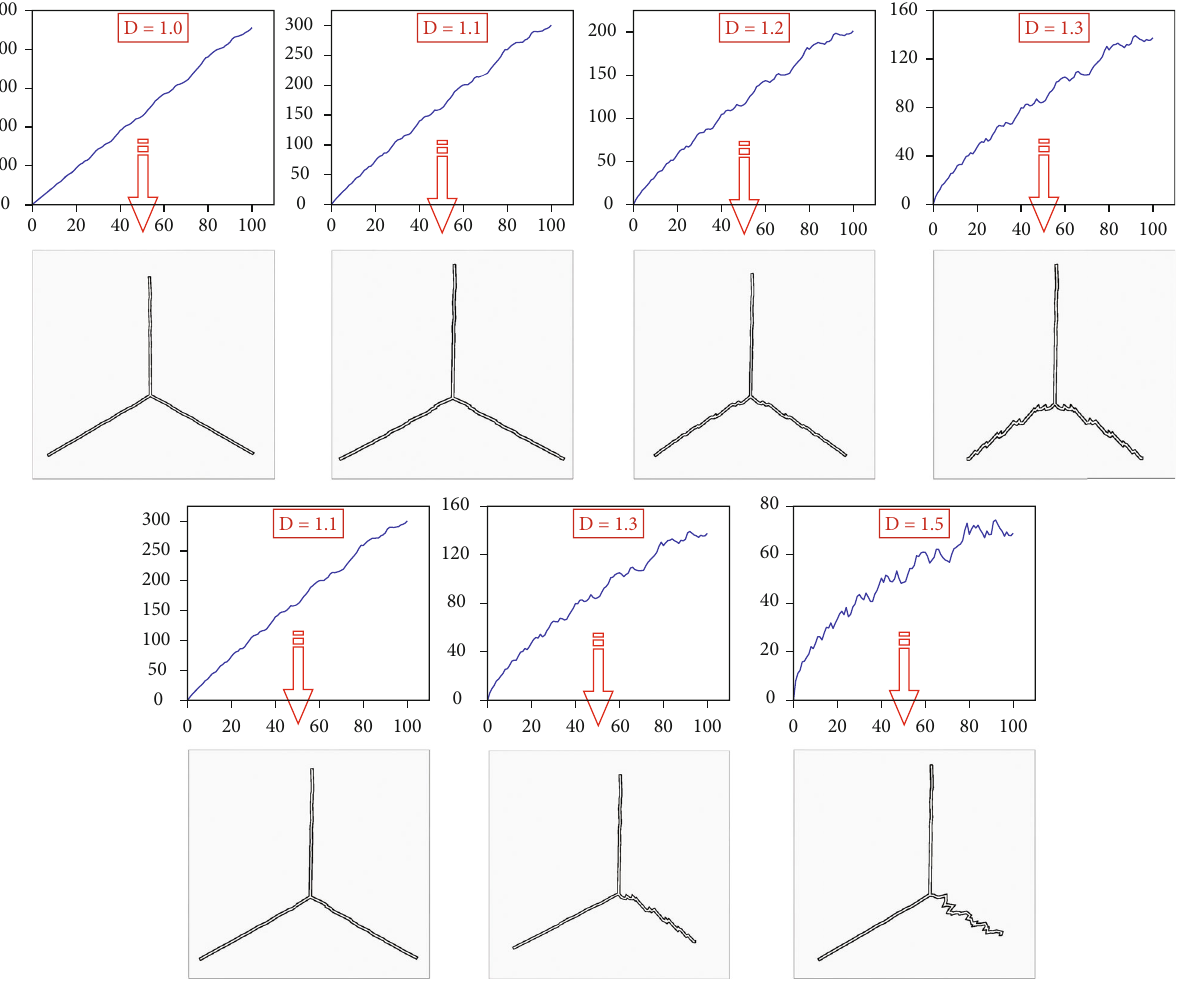
Figure 2: Establishing a Y-shaped fracture model based on the fractal curve. Table 1: Parameters of the Y-shaped